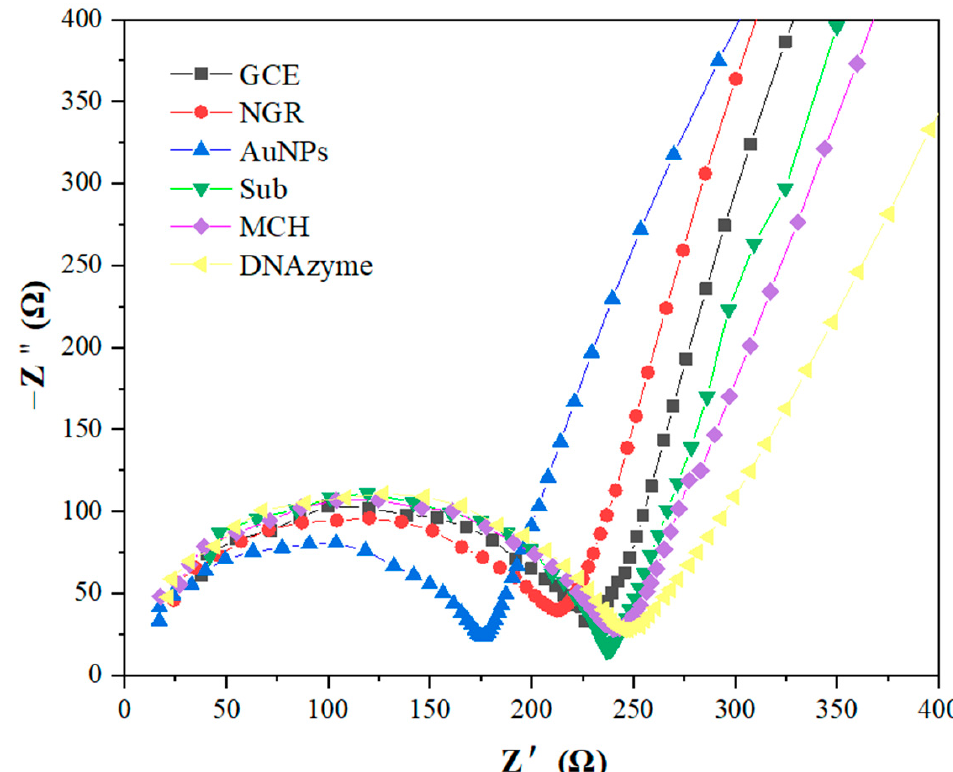
Figure 5. In 5 mmol/L [Fe(CN)6] 4 − /3 − and 0.1 mol/L KCl solution, GCE modified with NGR, AuNPs, Sub, MCH, and DNAzyme obtained EIS in the frequency range from 0.1 to 10 5 Hz (potential = 0.2